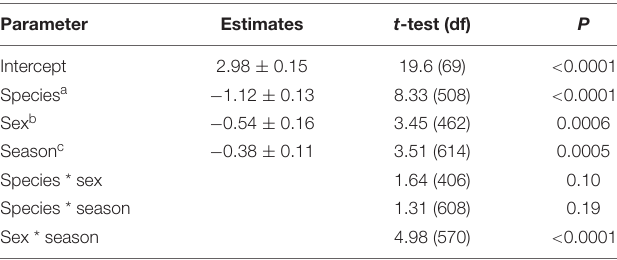
TABLE 2 | Linear mixed model parameter estimates for important drivers of squirrel home range size (ln transformed).